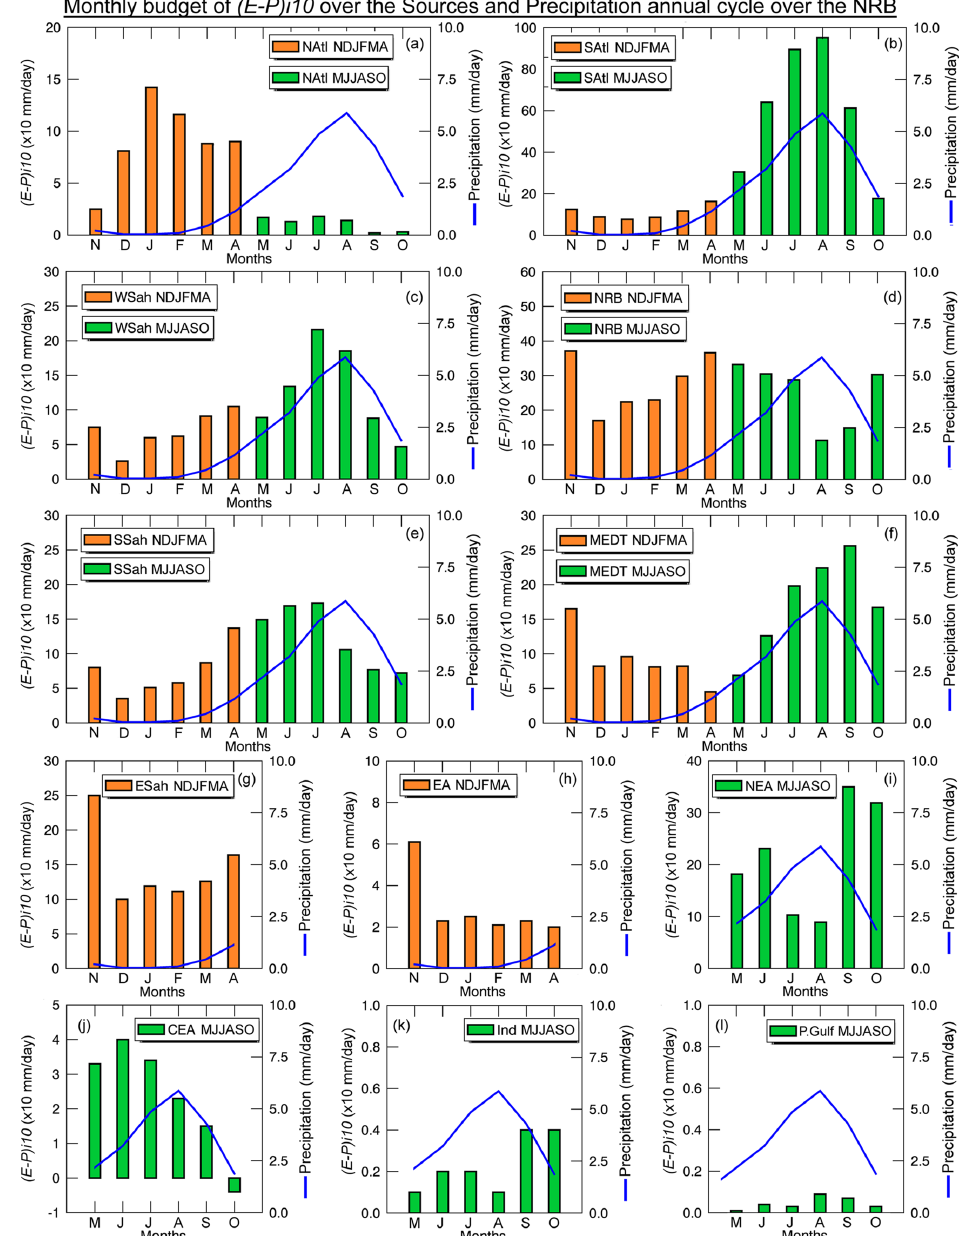
Figure 7. Climatological monthly (E – P)i10 values backward integrated from the Niger River Basin over the sources in NDJFMA–MJJASO (bar columns in orange and green, respectively) and precipitation over the NRB (blue line). The acronyms of the sources regions correspond with those given in Figure 5, in the order from ( a ) to ( l ). ( E – P)i10 from FLEXPART running and precipitation from CRU, for the period